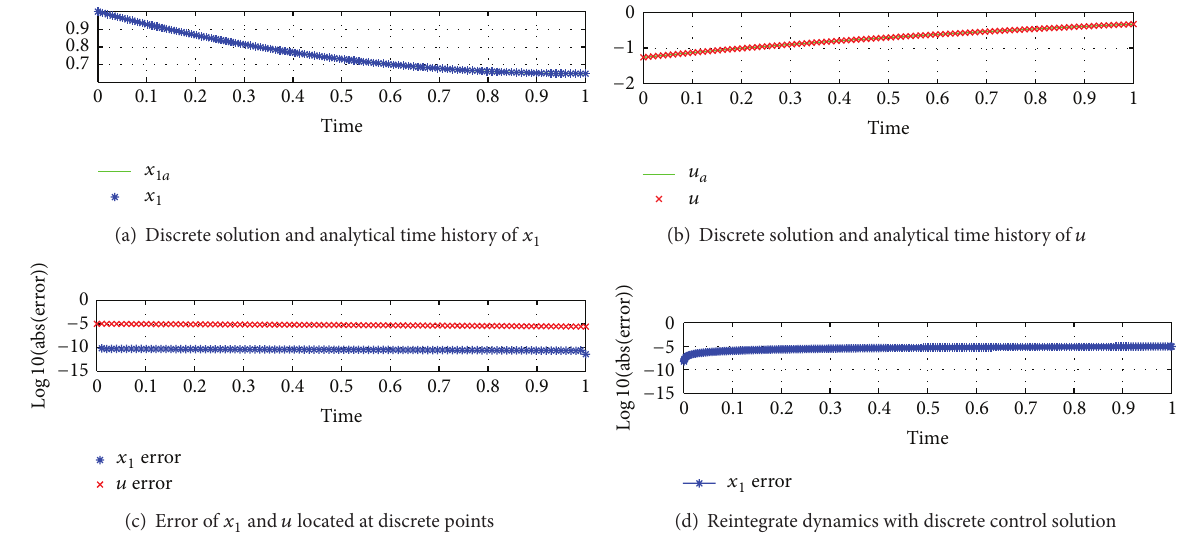
Figure 8: Simulation results of Example 1, 100 points.